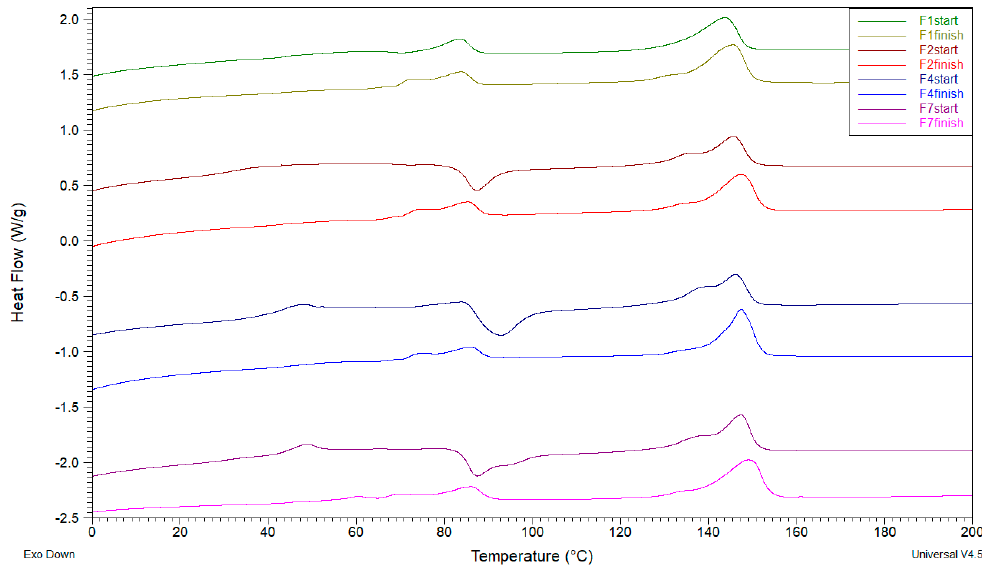
Figure 5. Comparison between thermograms before and after the migration test (first heating). Table 5. DSC results for F1, F2, F4, and F7 formulations at the beginning and at the end of the migration test (first heating).